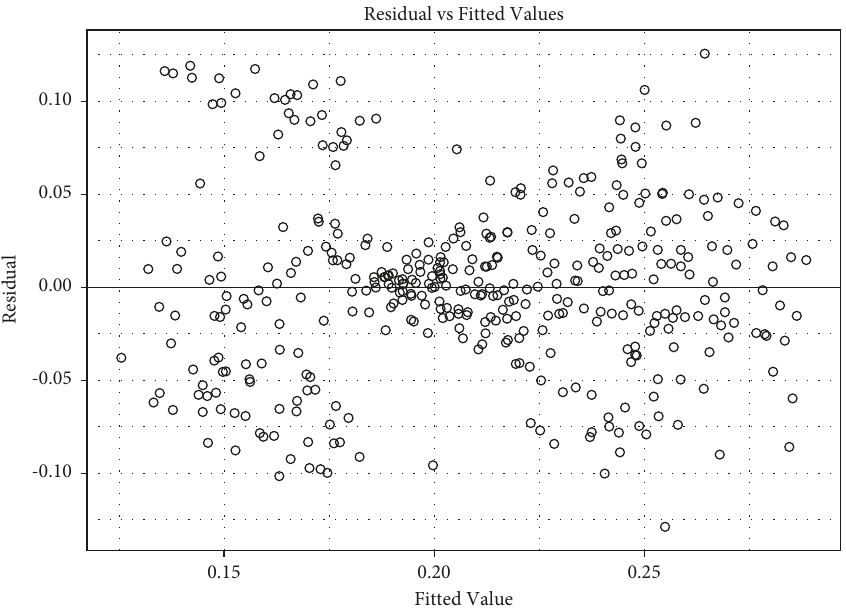
Figure 4: Residuals versus fitted values plot for the model with interaction effect of road type and temperature. Table 9: Extended ANOVA table of the road type analysis with interaction effect of road type and